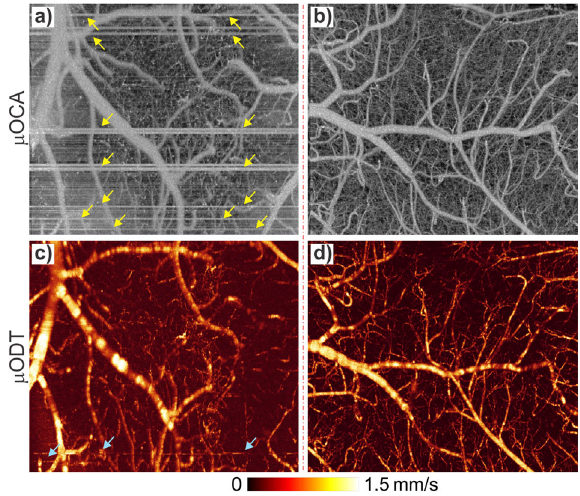
Fig. 1 Maximum-intensity-projection (MIP) images of 3D μ OCA and μ ODT of awake mice before and after OCT probe redesign and animal treadmill training. Left panels: μ OCA ( a ) and μ ODT ( c ) images acquired with previously reported OCT scanner; right panels: counterparts acquired with redesigned OCT scanner after animal training ( b , d ). Yellow and light blue arrows point to motion artifacts in μ OCA and μ ODT images, respectively. Image size: 2.3 × 1.2 × 2 mm 3